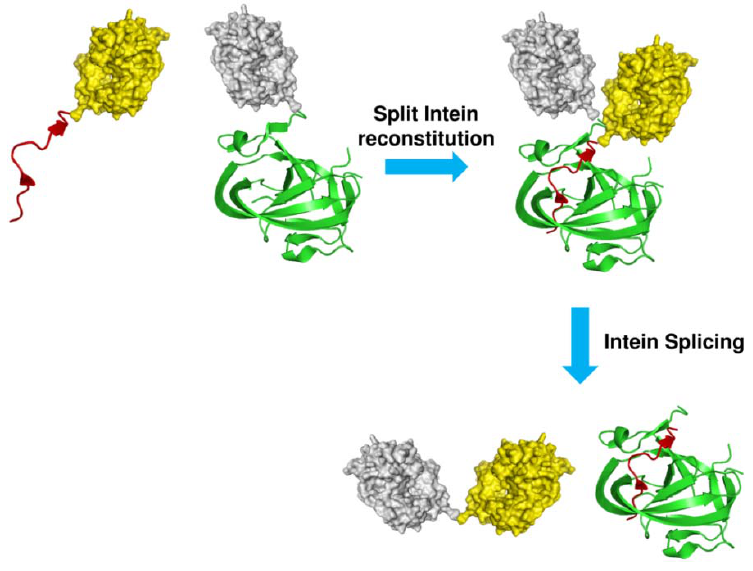
Figure 6. Schematic representation of the protein trans splicing reaction. Target proteins (yellow and gray) are fused to N- (IntN, red) and C-terminal (IntC, green) split intein fragments. After reconstitution, intein splices releasing the two target proteins linked through an amide